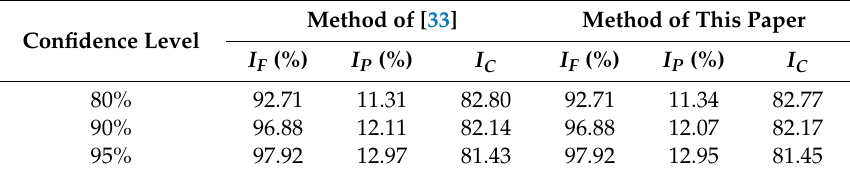
Table 1. Model comparison data at different methods of natural gradient.